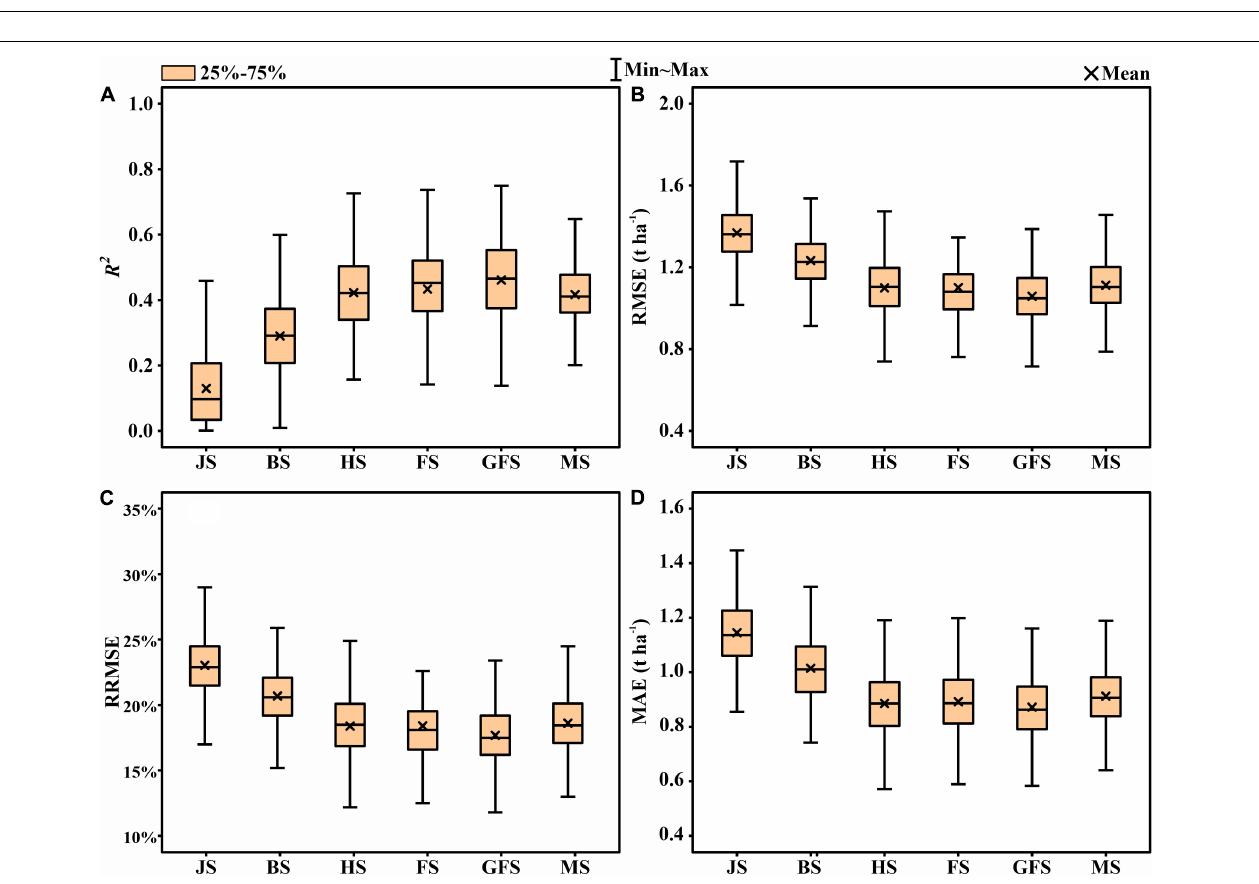
FIGURE 5 | Statistical distributions of (A) coefficient of determination ( R 2 ), (B) root mean square error (RMSE), (C) relative root-mean-square error (RRMSE), and (D) mean absolute error (MAE) of the elastic net regression (ENR) algorithm for GY prediction using multispectral features in test phases. JS, jointing stage; BS, booting stage; HS, heading stage; FS, flowering stage; GFS, grain filling stage; MS, maturity stage.